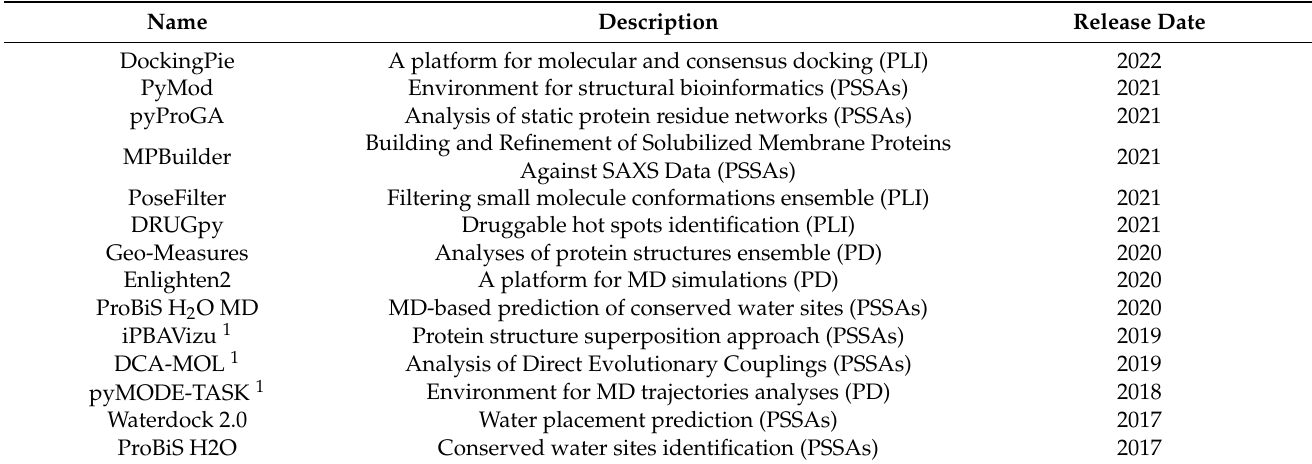
Table 1. Summary of the available PyMOL plugins for CPA, released in the last